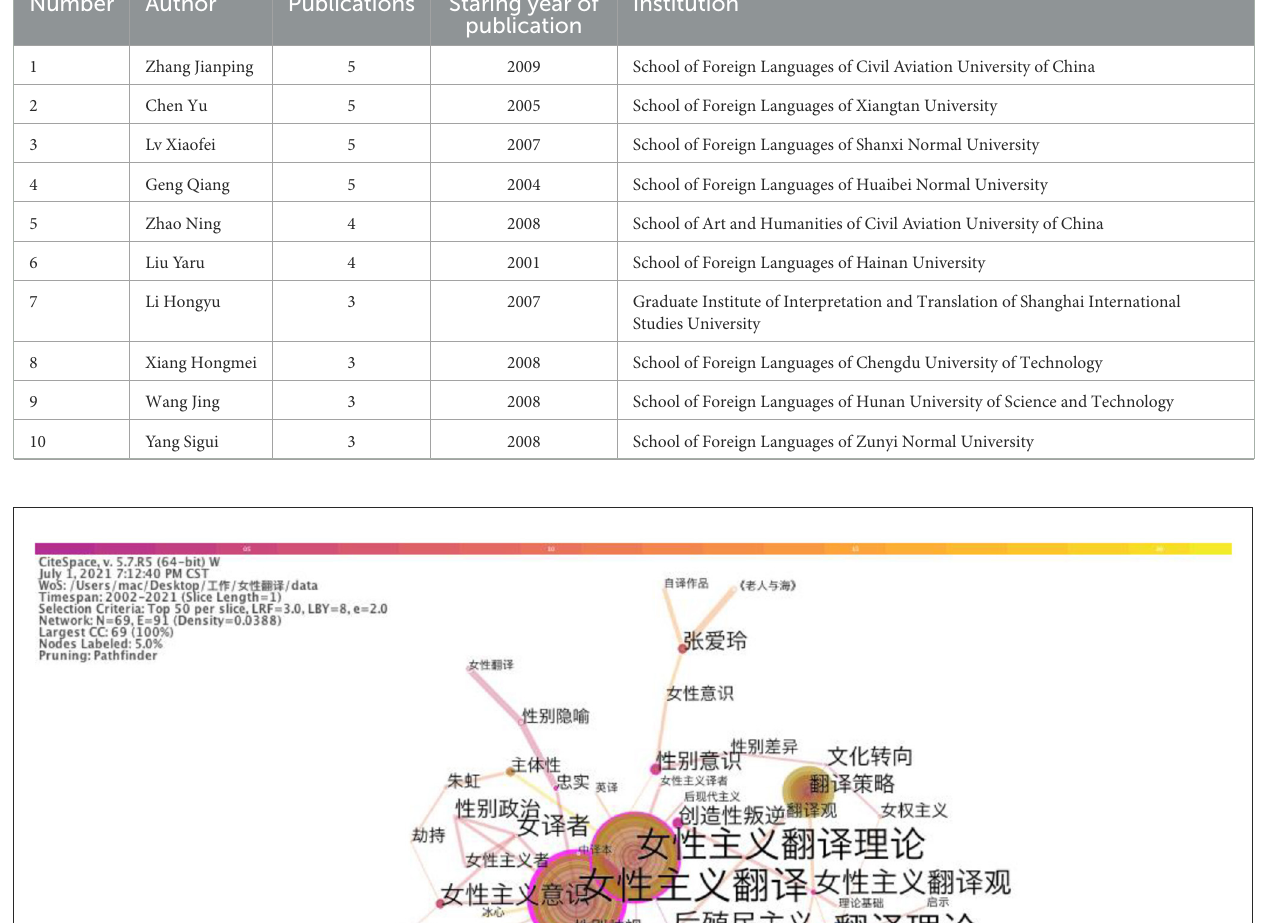
Chang, 2018). The clustering relationship of keywords is shown in Figure